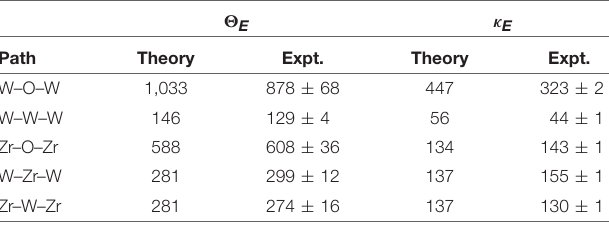
Frontiers in Chemistry |